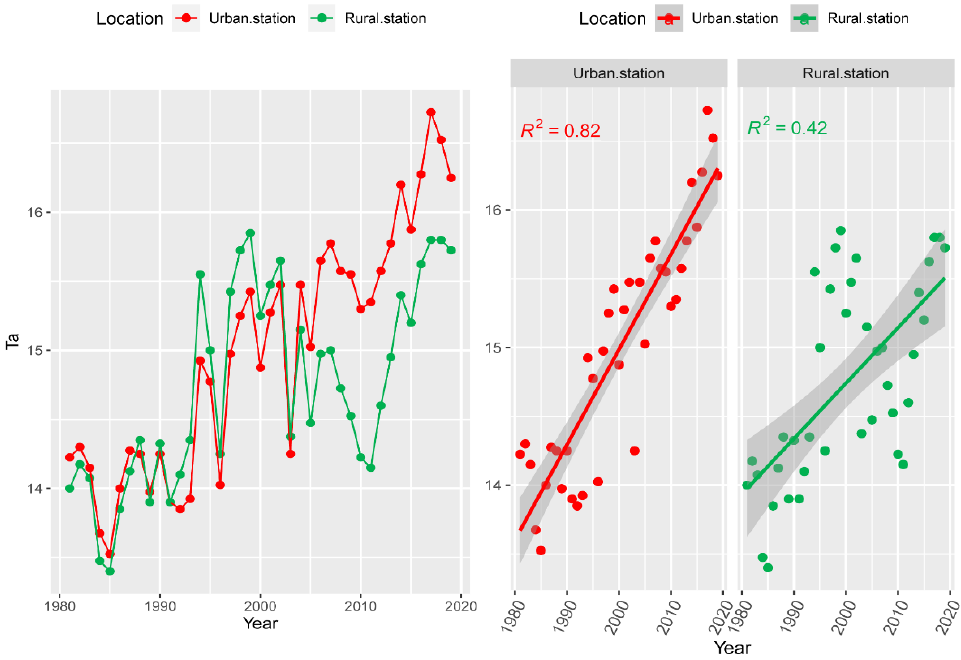
Figure 2. Mean annual temperatures were recorded at two weather stations between 1981 and 2019.